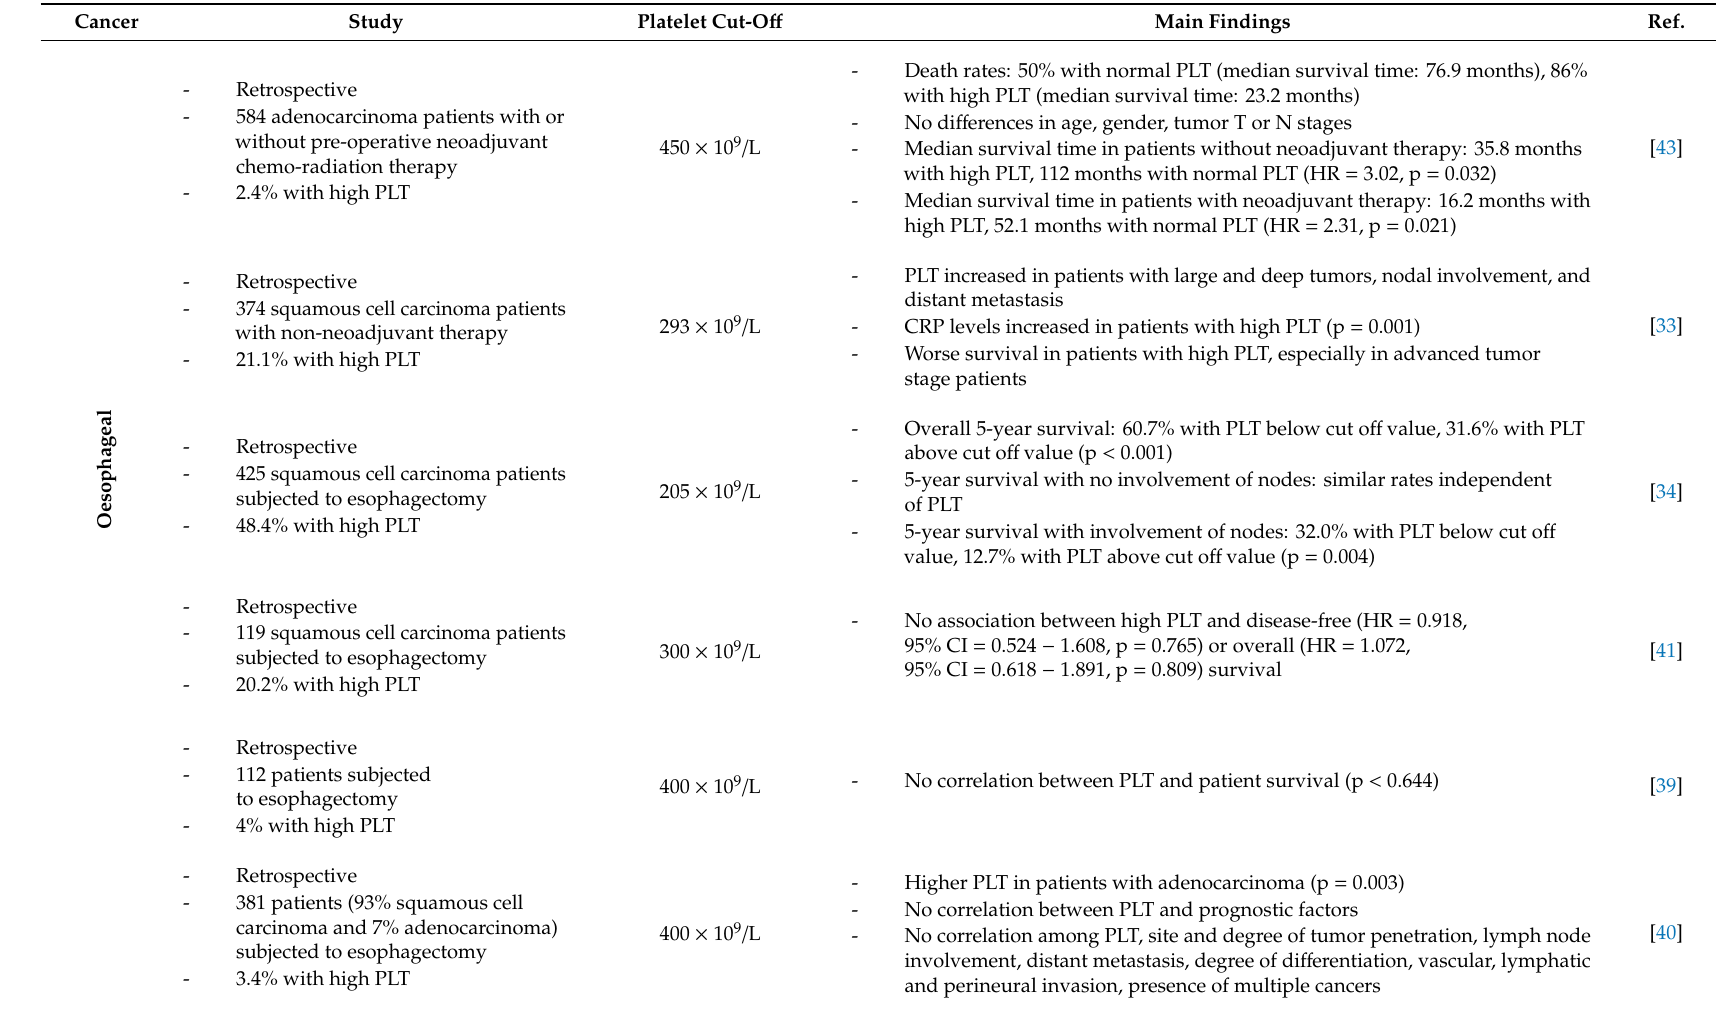
Table 1. Main findings on the relationship between high platelet count 1 and